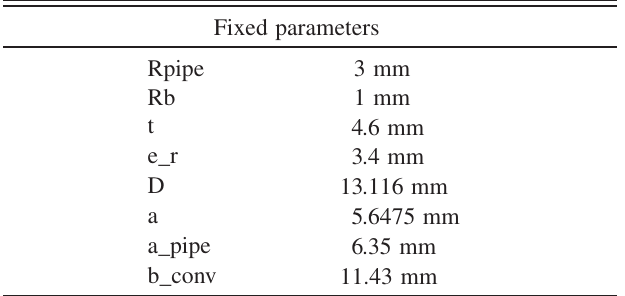
TABLE I. Fixed parameters for PBG structure, values for Fig. 5(a).